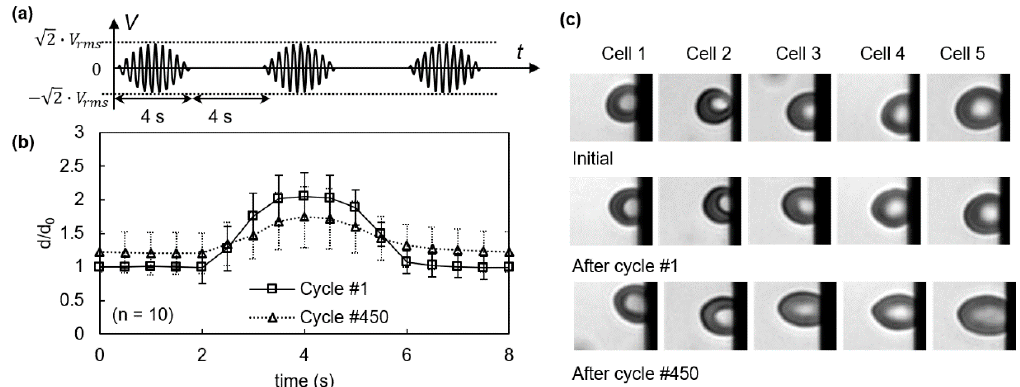
Figure 3. Electrodeformation of erythrocyte membranes during cyclic sinusoidal waveforms. ( a ) Electrical excitation was supplied to the erythrocyte suspension, each cycle consists of a duration for 4 s and a relaxation for 4 s. V rms value is 2 V. ( b ) Displacement of erythrocyte membrane to the electrode edge as a function of time ( n = 10) during the 1st and 450th cycles, respectively. Error bar represents the standard deviation. ( c ) Morphological of cells before electrodeformation and after the 1st and 450th cycles of electrodeformation.